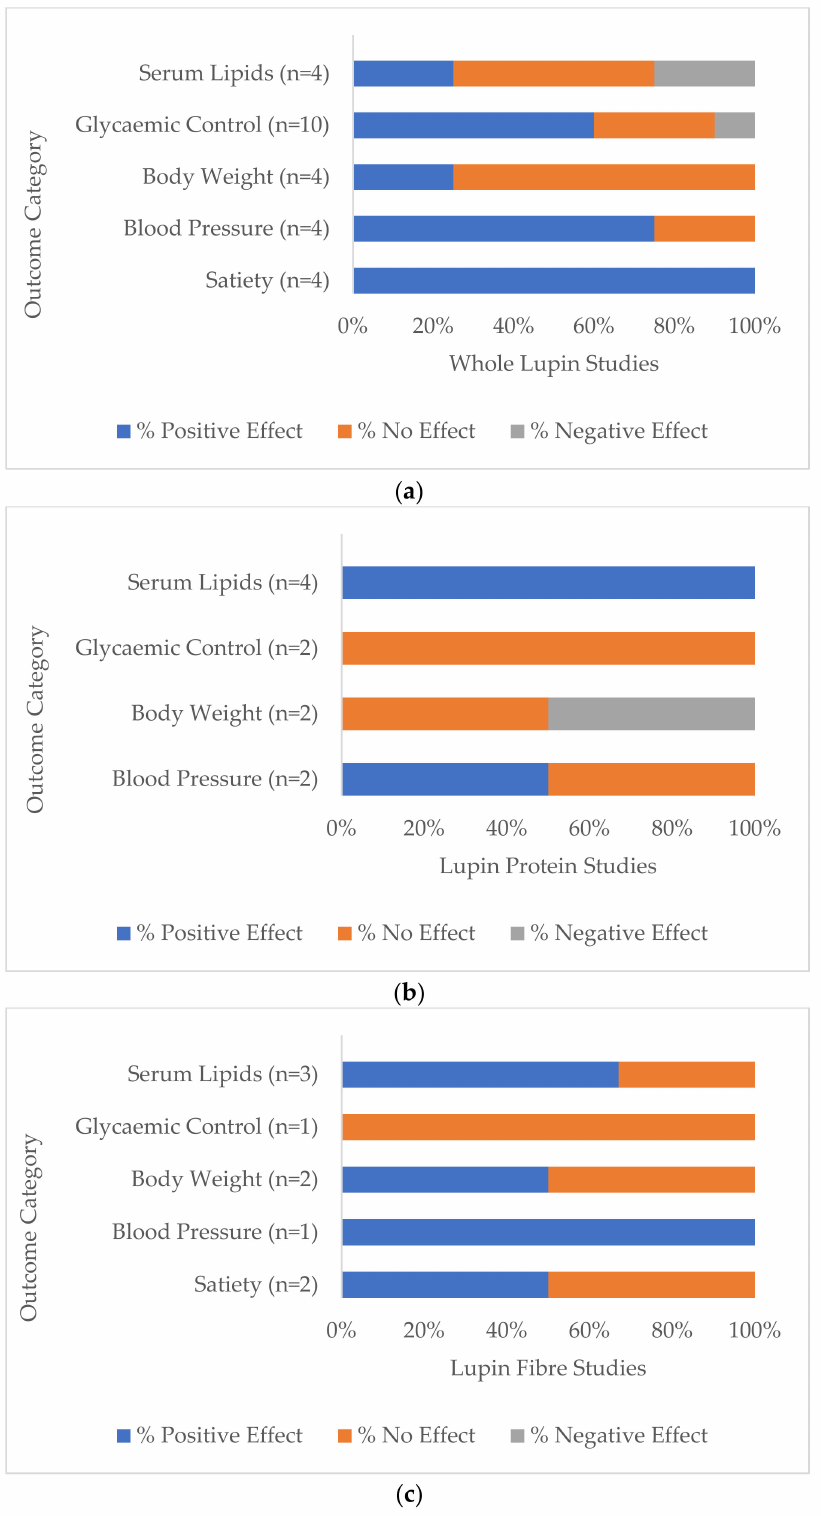
Figure 4. Percentage of total studies categorised by ( a ) whole lupin, ( b ) lupin protein and ( c ) lupin fibre treatment that reported positive (potentially beneficial), negative (potentially detrimental) and no significant differences between baseline and/or comparators ( p < 0.05) in the five most investigated groups of health markers: serum lipids, glycaemic control, body weight, blood pressure and